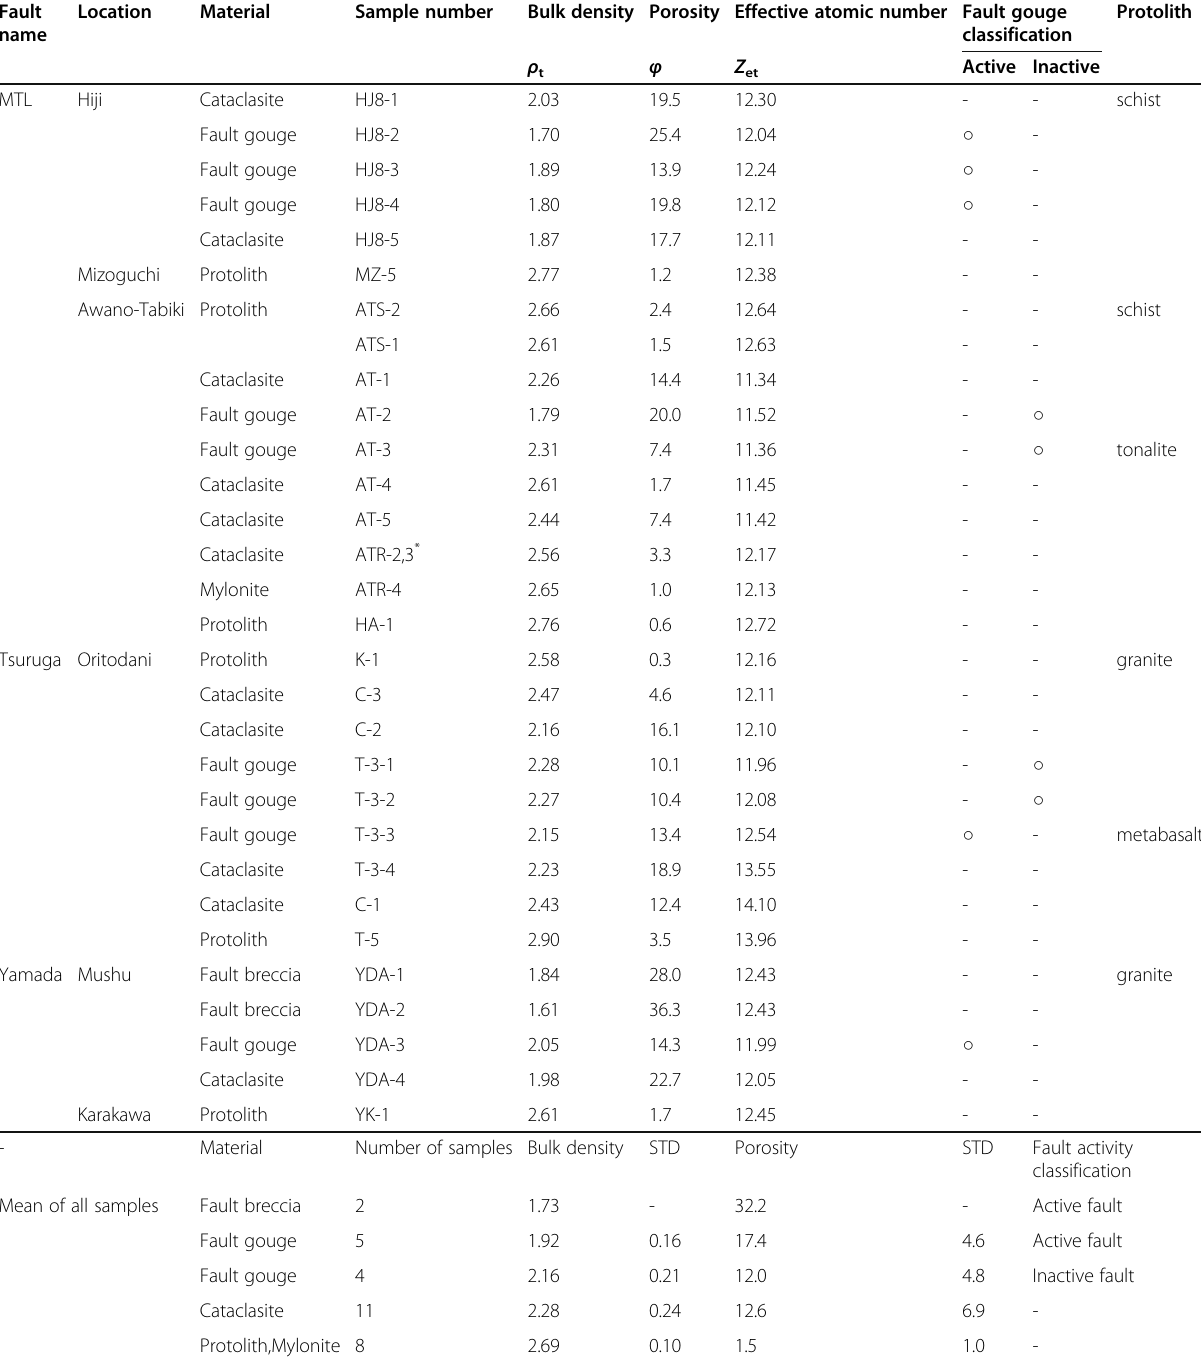
Table 2 Density, porosity, and XRF analysis results Fault name